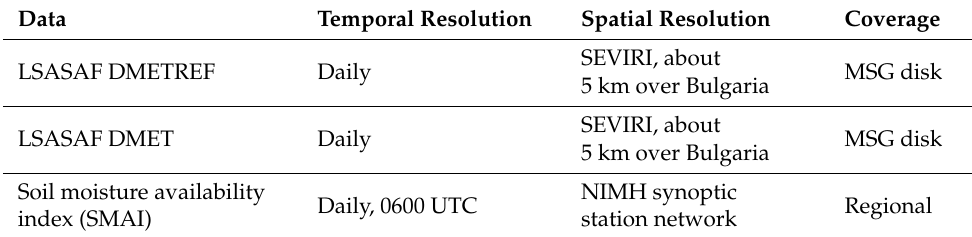
Table 1. Characteristics of the data from Meteosat and